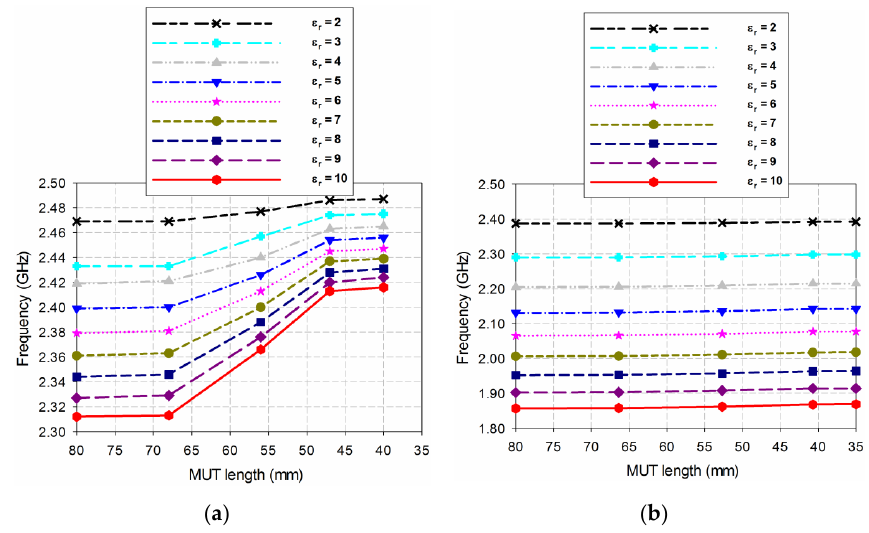
Figure 7. Variations on the resonant frequency of the conventional and proposed patch antennas when varying the length of the material under test (MUT): ( a ) Conventional f r1 ; ( b ) proposed f r1